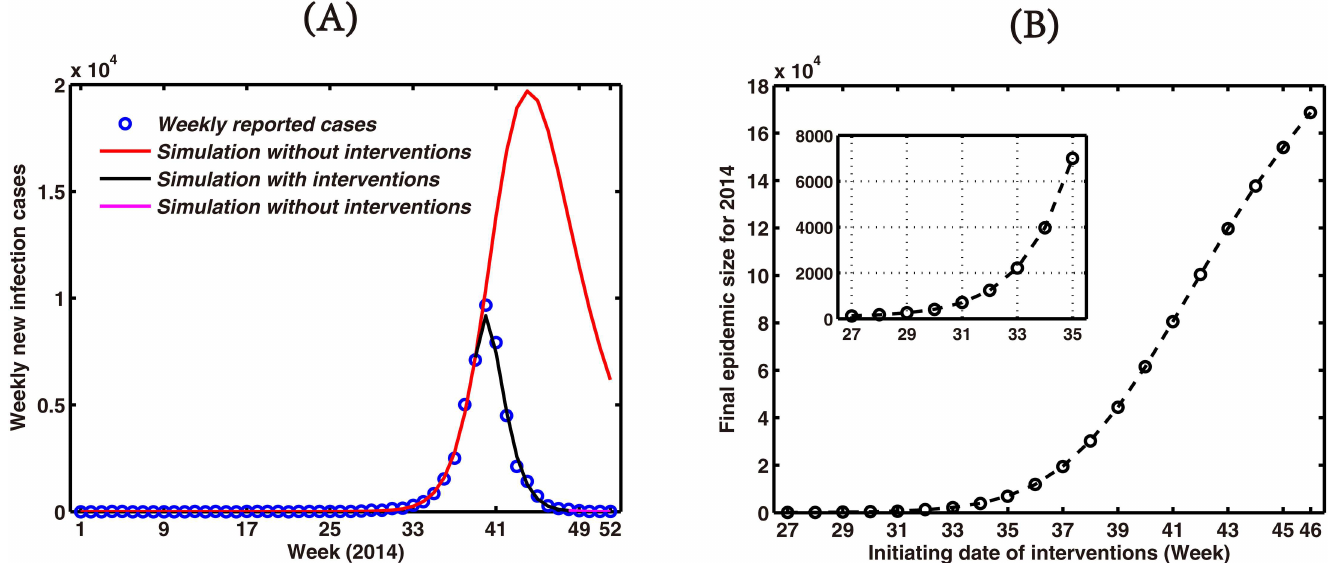
Fig 9. The comparison simulation result between with and without interventions. (A) Weekly new infection cases. (B) Simulations of the final outbreak size for 2014with different